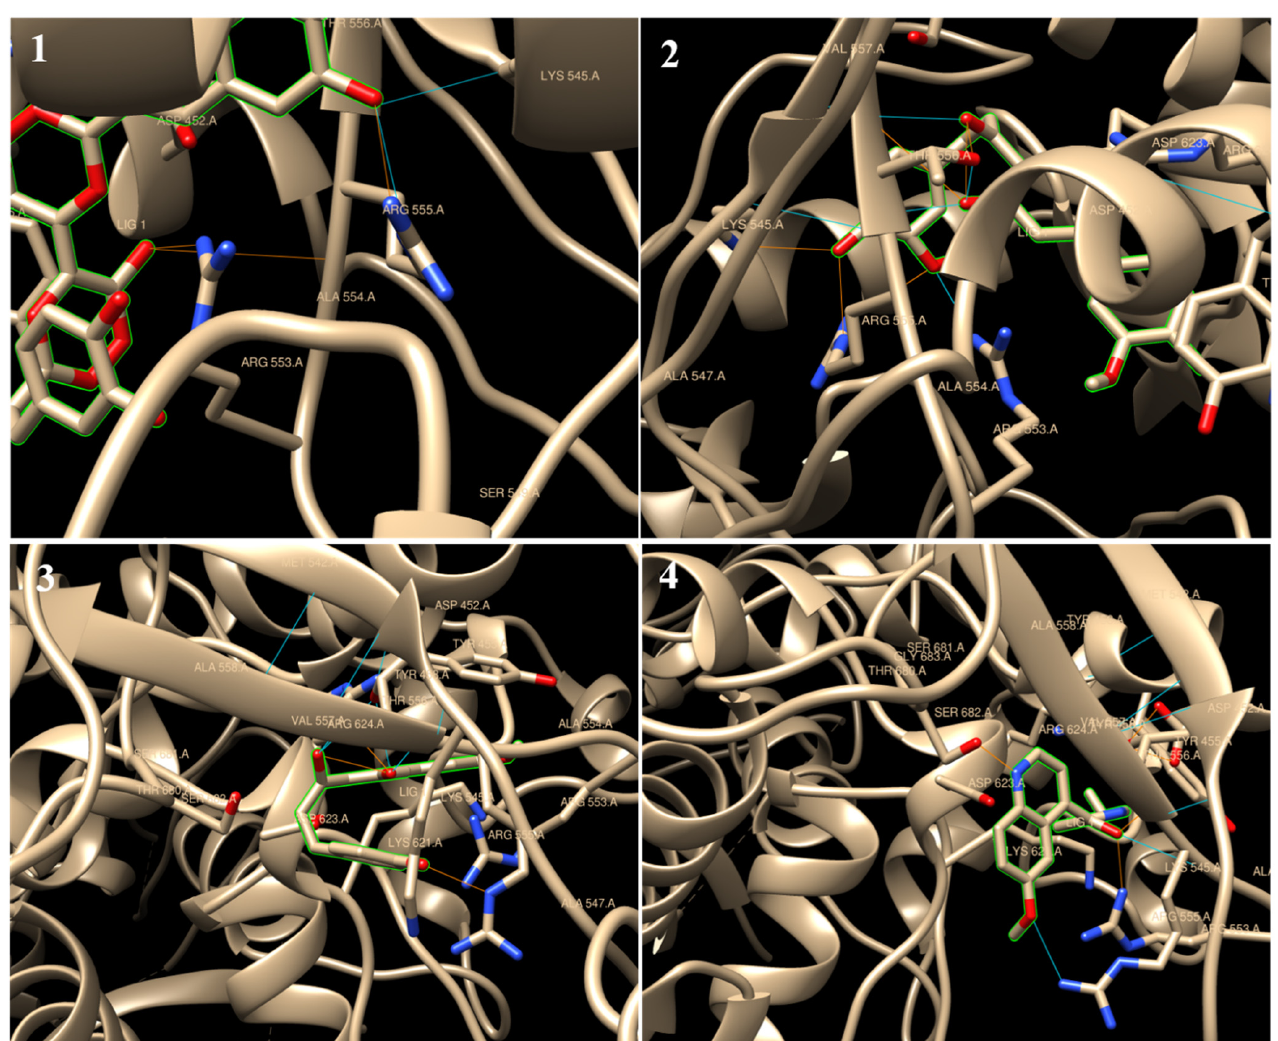
Figure 5. Chimera visualization of 6M71 docking with chicoric acid ( 1 ), curcumin ( 2 ), demothoxycurcumin ( 3 ) and quinine ( 4 ). The yellow dots show H-bonds. Curcumin (CC) and its analogues are the main phytonutrients of turmeric ( Curcuma longa L.) and other Curcuma spp., which are widely used around the world as culinary